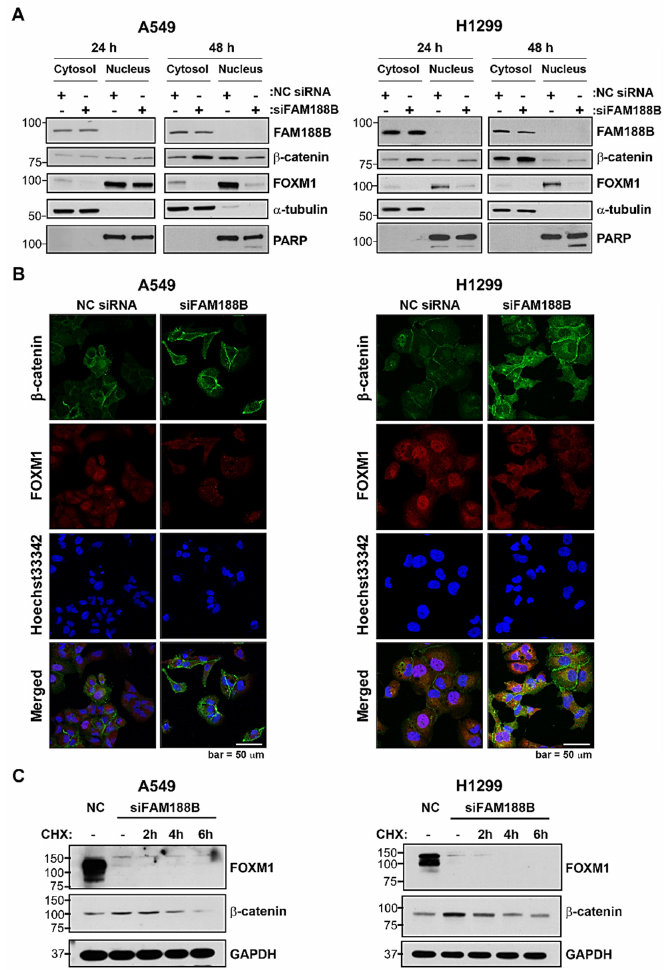
Figure 4. Effects of FAM188B knockdown on expression levels and nuclear translocation of FOXM1 and β -catenin ( A ) A549 and H1299 cells were transfected either with NC siRNA or siFAM188B for indicted times. Cells were then fractionated into cytosolic and nuclear fractions, followed by immunoblot analysis using indicated antibodies. PARP and α -tubulin were used as a cytoplasmic and nuclear marker, respectively. ( B ) Cells treated as in ( A ) for 48 h were stained for β -catenin and FOXM1 and fluorescence images were captured using confocal microscope. Nuclei were stained with Hoechst33342. Scale Bar: 50 µ m ( C ) Cells were treated as in ( A ) for 48 h and were treated with cycloheximide (CHX) for 2–6 h before harvest. Total cellular proteins were analyzed by immunoblot using indicated antibodies. These experiments were performed two times independently with similar